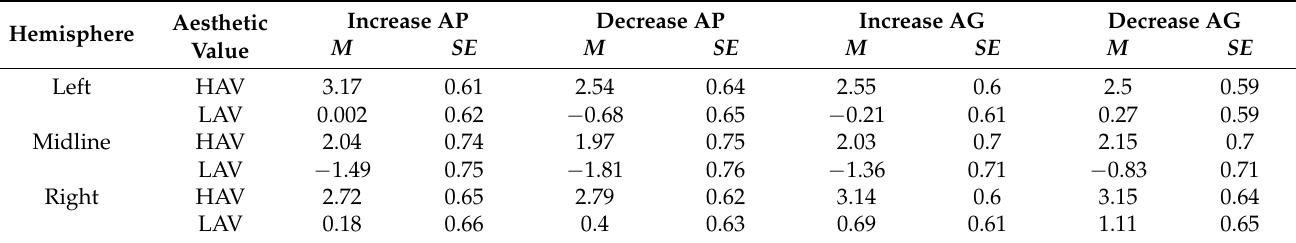
Table 6. N2 amplitudes (mean and standard